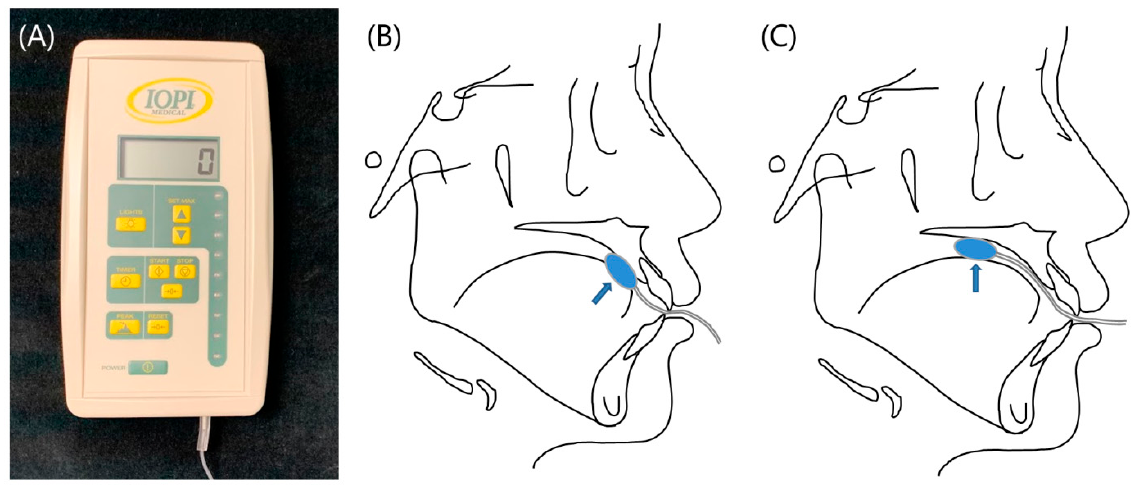
Figure 2. ( A ) Iowa Oral Performance Instrument (IOPI) device. ( B ) Position of the bulb (TAP, anterior tongue pressure). ( C ) Position of the bulb (TPP, posterior tongue pressure).